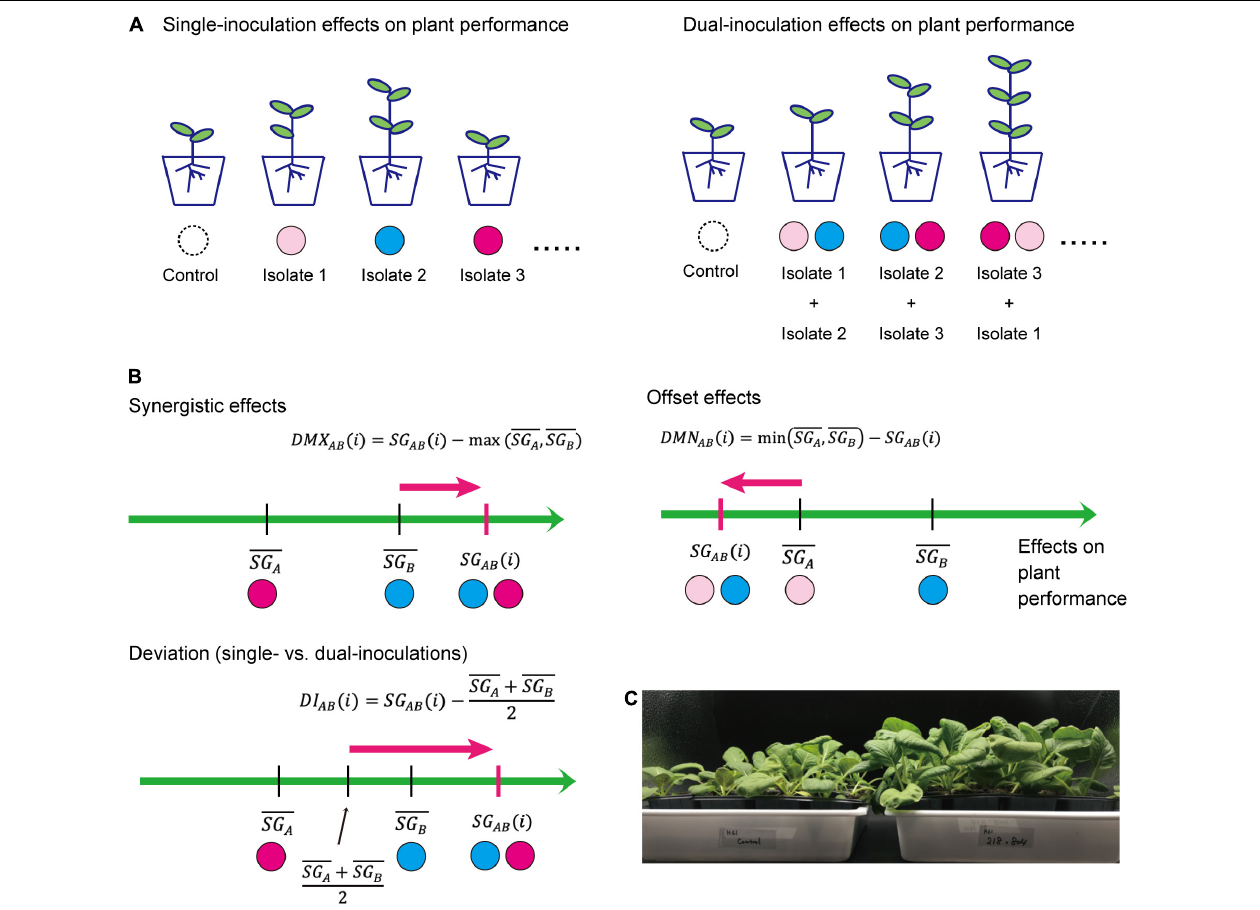
FIGURE 1 | Evaluation of effects on plant performance. (A) Schema of single- and dual-inoculation assays. (B) Indexes for comparing single vs. dual inoculation effects. Along the axis of standardized growth index defined by the Equation (1), index values representing synergistic/offset effects on plants are calculated for each replicate plant sample for each pair of microbial (fungal) isolates [ DMX AB ( i ) and DMN AB ( i ) ]. Likewise, index values representing deviation of dual-inoculation effects from single-inoculation effects are obtained [ DI AB ( i ) ]. (C) Example of inoculation experiments. Brassica plants inoculated with two fungal isolates (tri_0218 × ste_0804; right) and those without fungal inoculations (control;